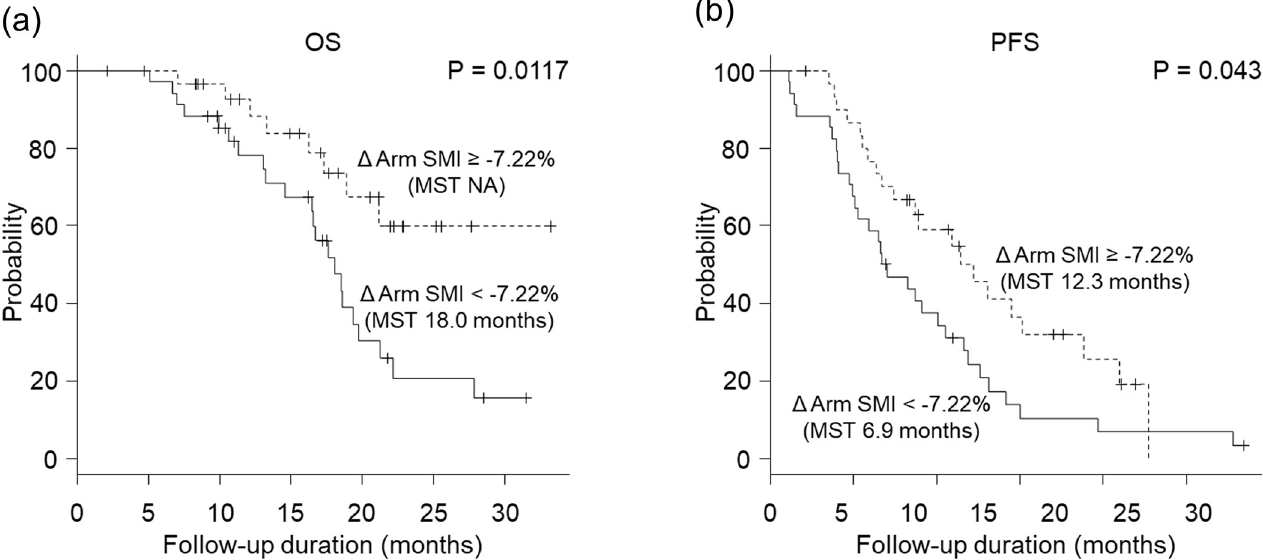
Fig 6. Association between the rate of change in body composition and prognosis. The group with ECW/TBW � 0.400 before lenvatinib treatment with a rate of change in the arm skeletal muscle mass index (SMI) above the median had a significantly longer (a) overall survival (OS) (data not available vs 18.0 months, P = 0.0117) and (b) progression-free survival (PFS) (12.3 months vs 6.9 months, P = 0.043) than the group with a rate of change in the arm SMI below the